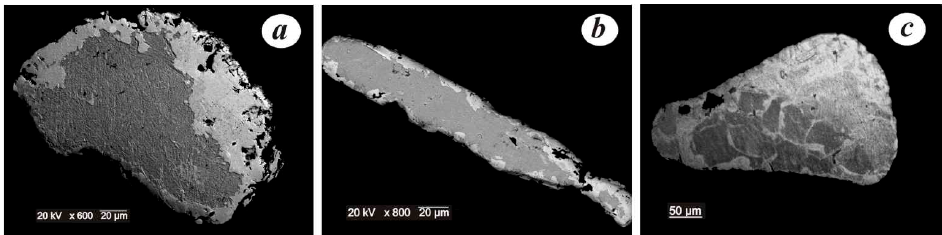
Figure 8. The internal structure of placer gold of the sources of the rivers of the Kempendyai dislocations: ( а ) monocrystalline structure with a dense high-grade shell with a thickness of 20–40 microns; ( b ) very thin fragmentary high-grade shell on low-grade gold; ( c ) intergranular high-grade veinlets. Discovery of porous spongy placer gold up to 40% (Figure 5a,b) with an